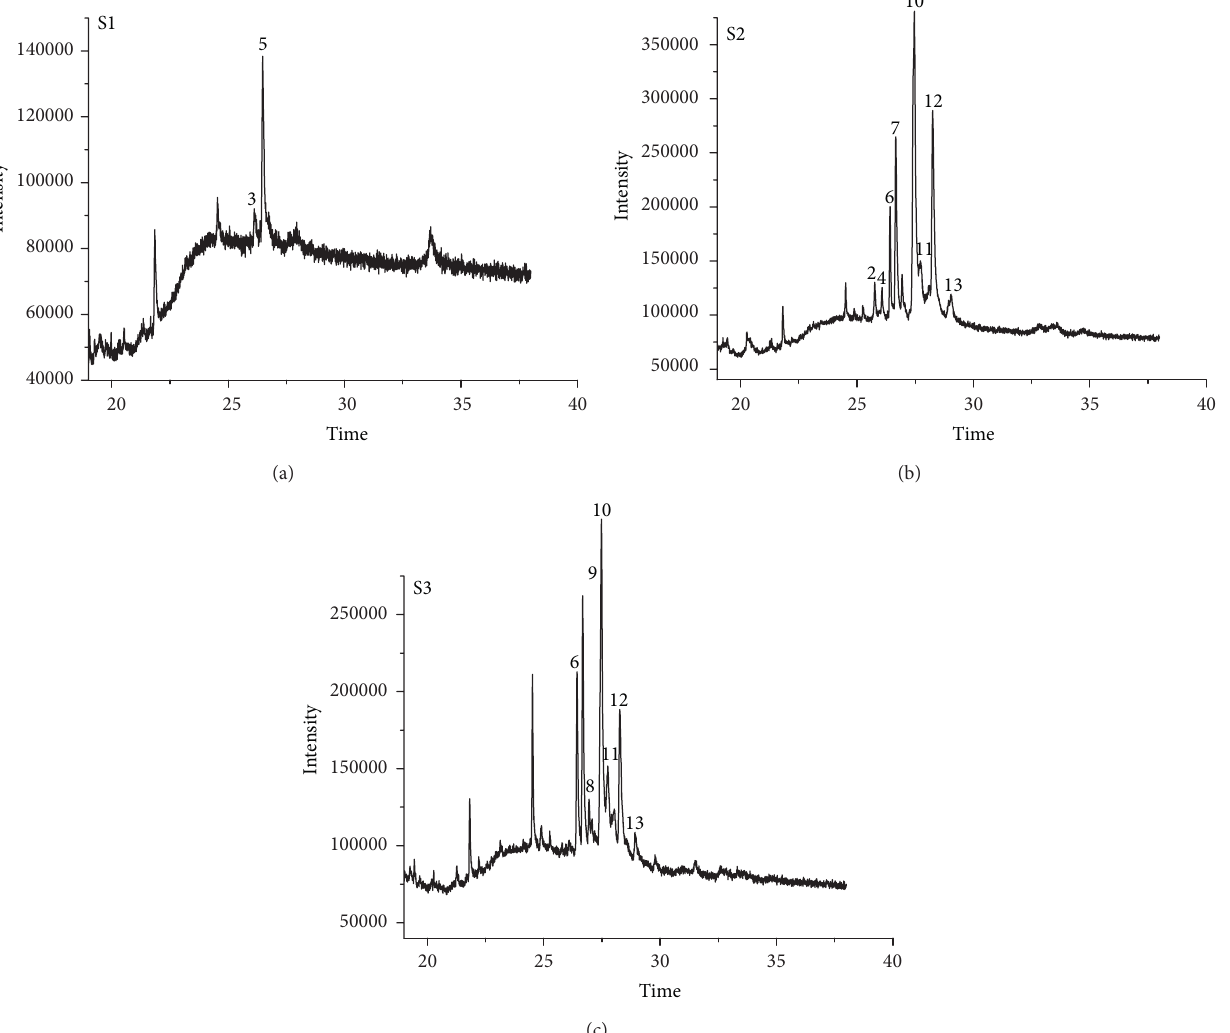
Figure 1: Total ion current chromatograms of RC. S1: processed RC sample extracted with methanol, S2: crude RC sample extracted with methanol, and S3: crude RC sample extracted with acetone. (a) The total chromatogram and (b) the enlarged chromatogram after 19min. The peak number is consistent with Table 1. 4# and 5# (+)-corydaline. Column: HP-5-MS column, injector temperature: 260 ∘ C, GC oven temperature program: 40 ∘ C (does not hold), at 40 ∘ C/min to 110 ∘ C (does not hold), at 8 ∘ C/min to 260 ∘ C (holds for 10